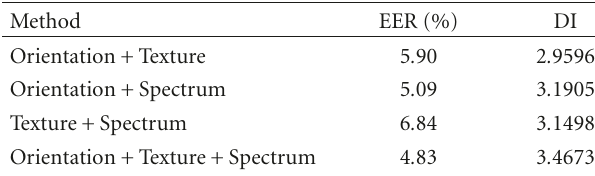
Table 3: Performance indexes for decision-level fusion of verifica- tion